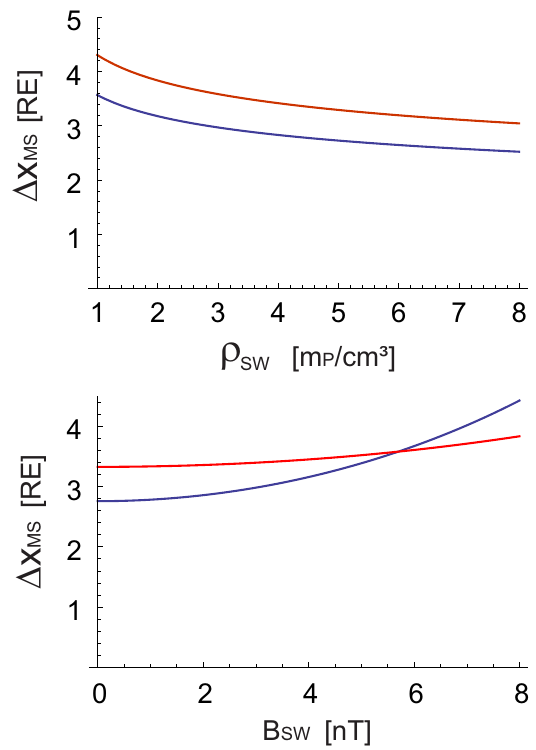
Fig. 5. Magnetosheath thickness of our model by Eq. (49) (blue curves) in comparison to the model by Farris and Russell (1994) (red curves). The upper plot shows the density dependence of the sheath thickness for u SW = 400kms − 1 , T SW = 2 × 10 5 K, and B SW = 0nT. The lower panel offers the magnetic field depen- dence for u SW = 400kms − 1 , T SW = 2 × 10 5 K, and ρ SW = 8 . 4 × 10 − 21 kgm − 3 = 5m P cm − 3 .